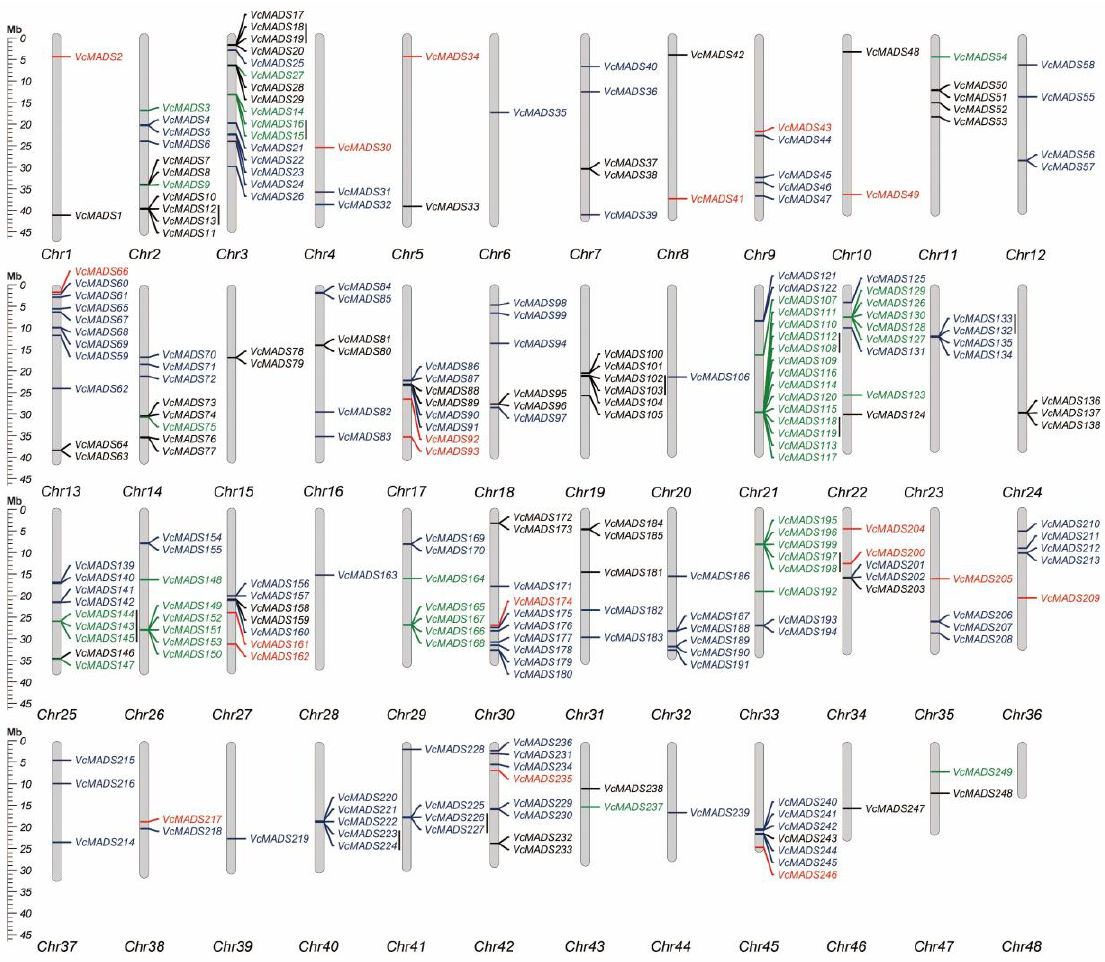
Figure 3. Chromosome location, distribution, and tandem duplication of MADS-box genes in 48 chromosomes of blueberry. M α , M β , M γ , and MIKC genes are shown in black, red, green, and purple, respectively. Vertical black lines indicate potential tandem repeat genes.